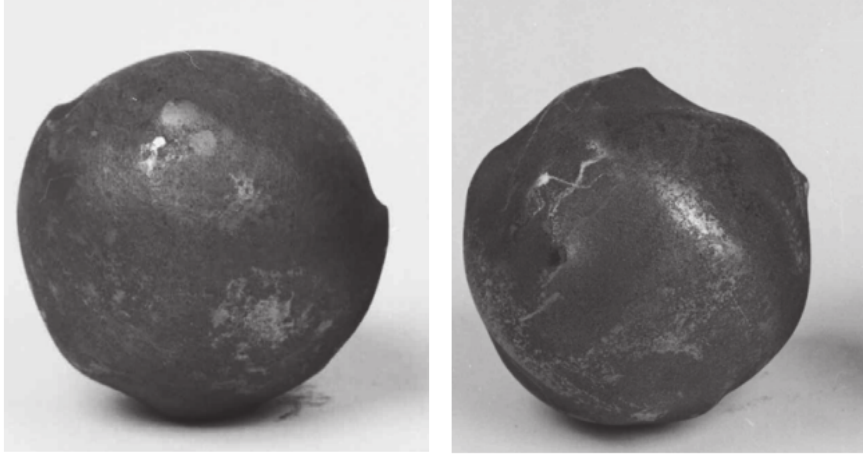
Figure 1: Shape of oxidized pebbles in SUPERNOVA